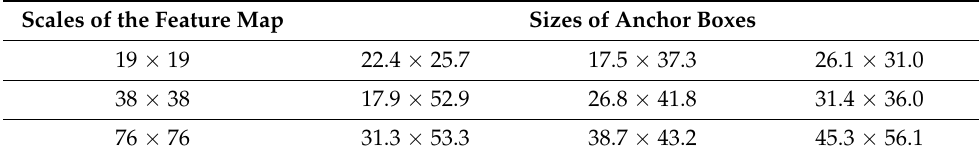
Table 2. Different sizes of anchor boxes in this study.